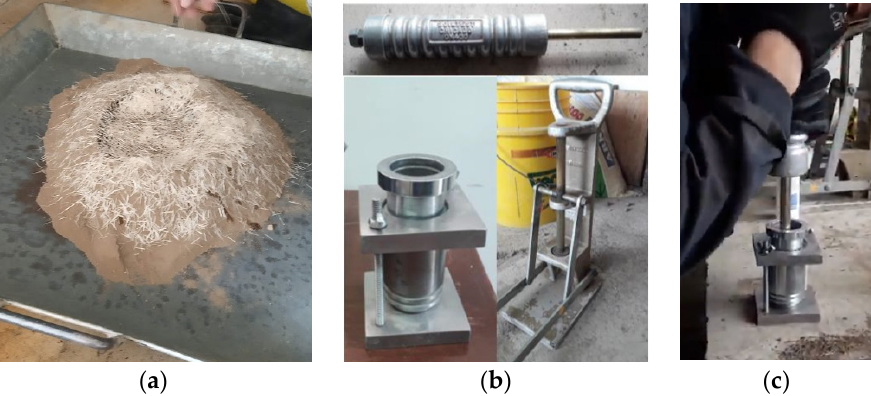
Figure 5. ( a ) Soil–Abaca fibers mixture, ( b ) Harvard Miniature Compaction Apparatus, ( c ) Sample compaction process.